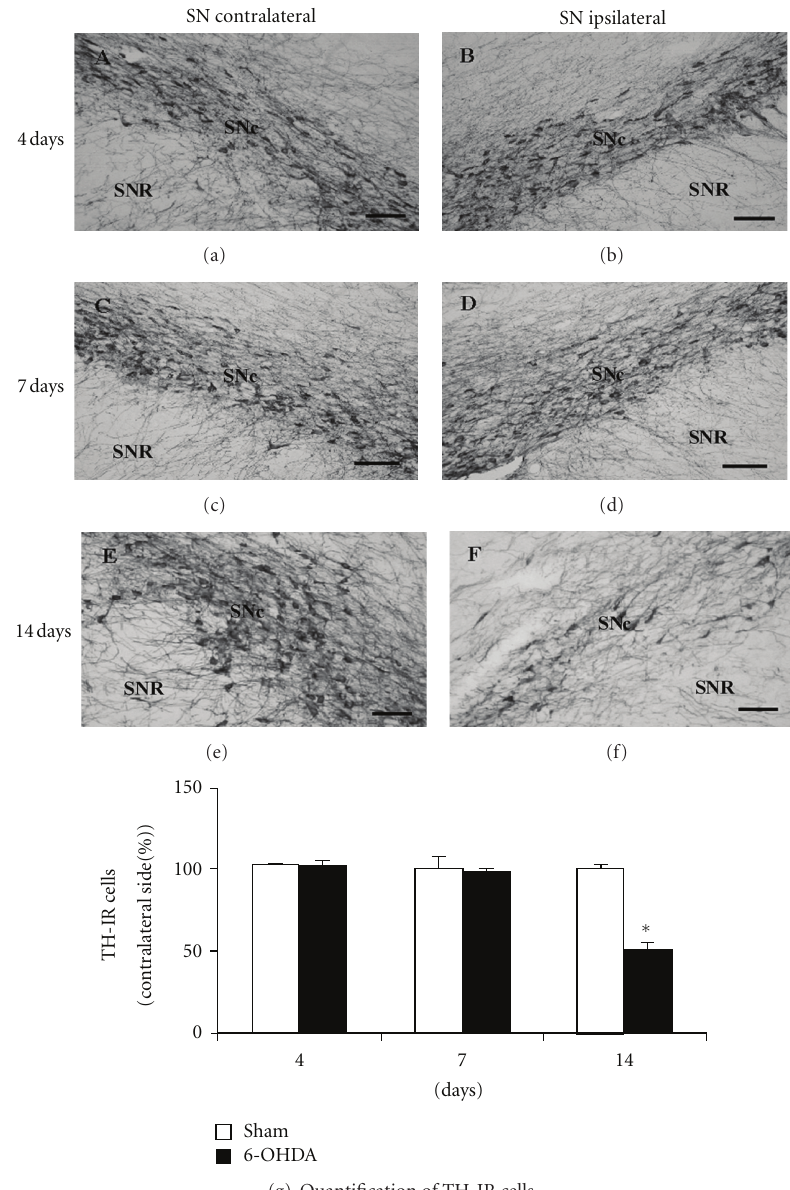
Figure 1: The unilateral intrastriatal injection of 6-OHDA induces a decrease in the number of TH immunoreactive cells in SNc that is only evident 14 days after the neurotoxin injection. Photomicrographs show TH-immunoreactive (IR) cells in the contralateral (a), (c), and (e) and ipsilateral (b), (d), and (f) side of rat SN 4, 7, and 14 days after unilateral 6-OHDA intrastriatal injection, respectively. (a)–(f) scale bar = 100 μ m. SNc: substantia nigra pars compacta; SNR: substantia nigra pars reticulata. (g) Percentage of TH-IR cells in the ipsilateral